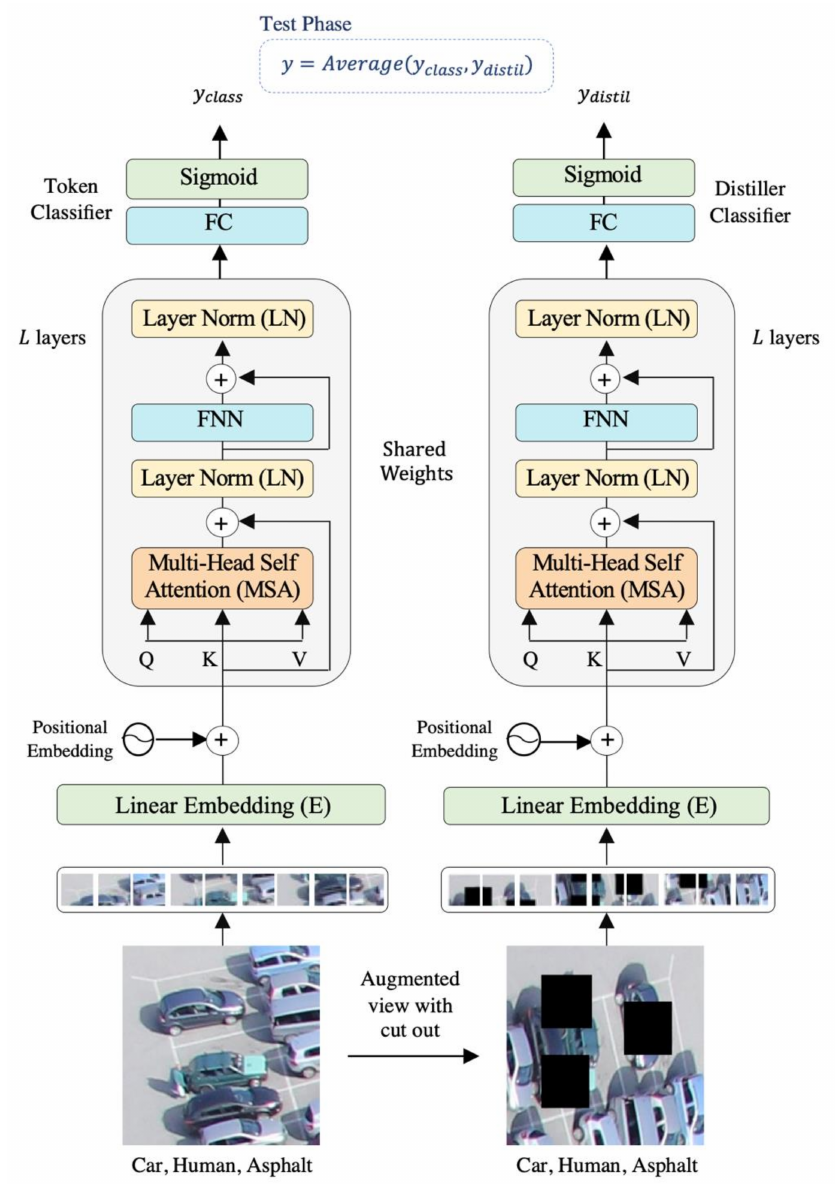
Figure 1. Proposed multi-labeling